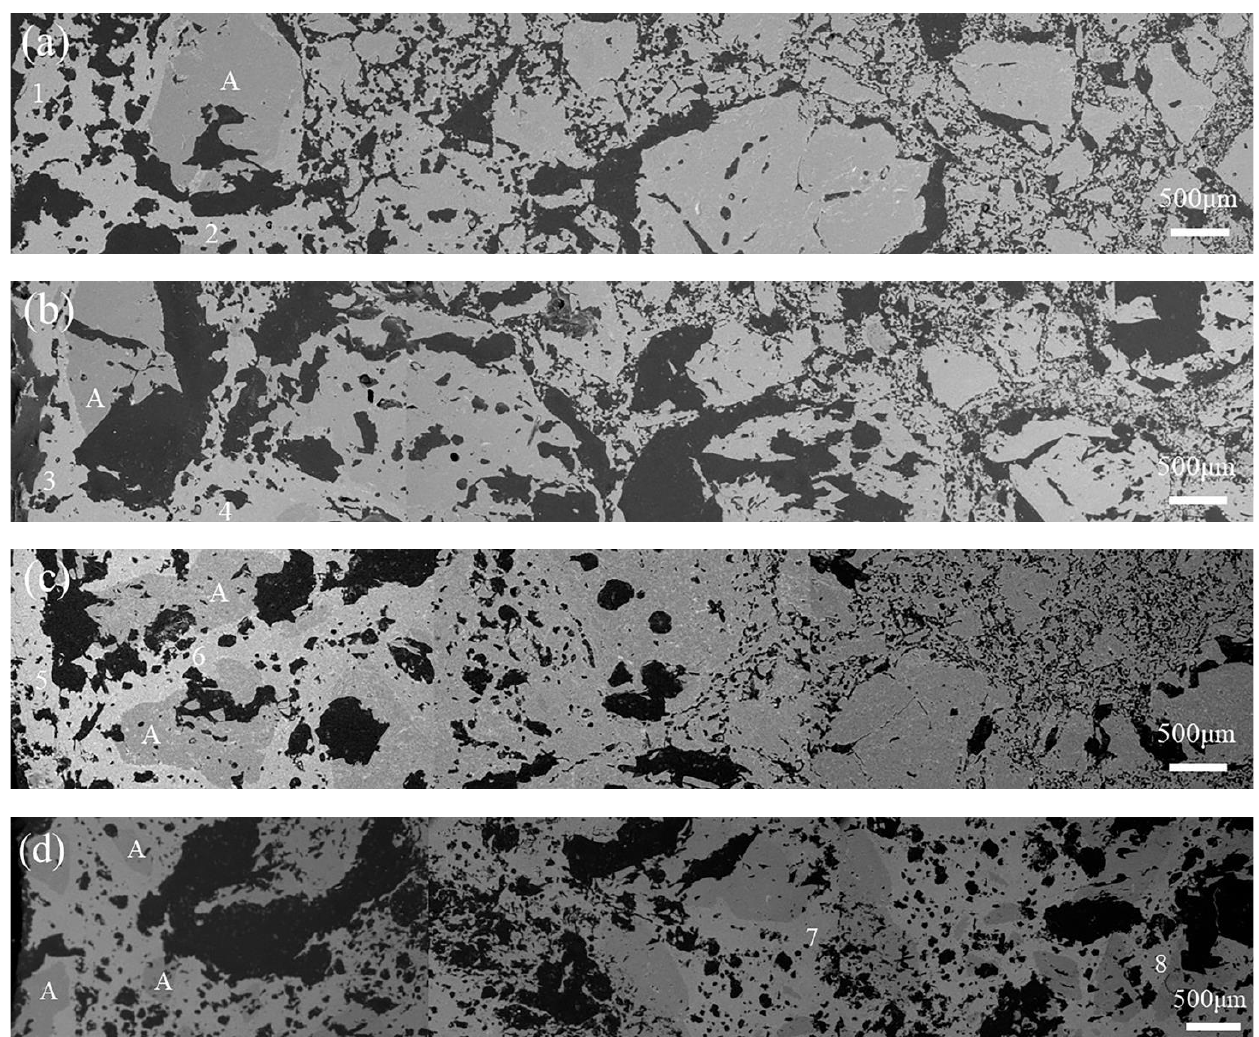
Figure 11. SEM images of corroded samples with slag heated at 1600 ◦ C for 3 h: ( a ) G0, ( b ) G2, ( c ) G4, and ( d ) G8 (A-Corundum). Table 5. EDS analysis of different zones in corroded samples (at.%).